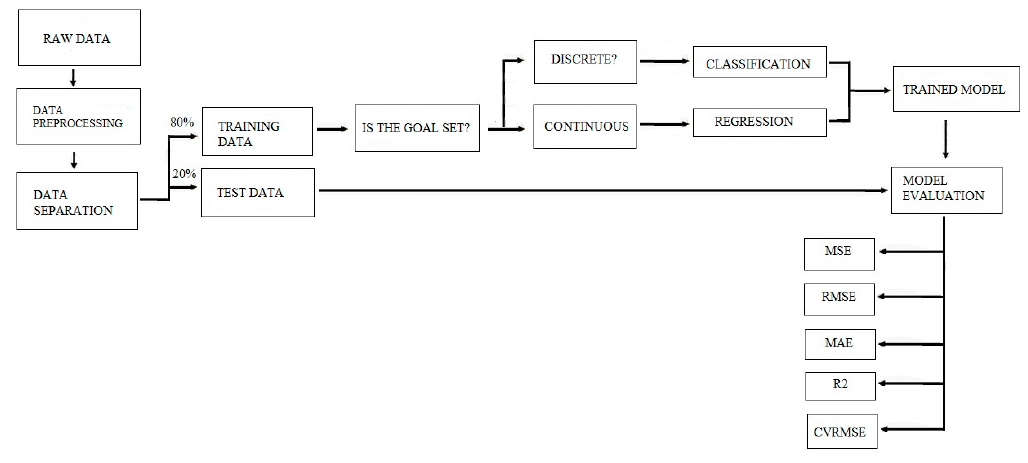
Figure 1. Flow diagram of the prediction method.